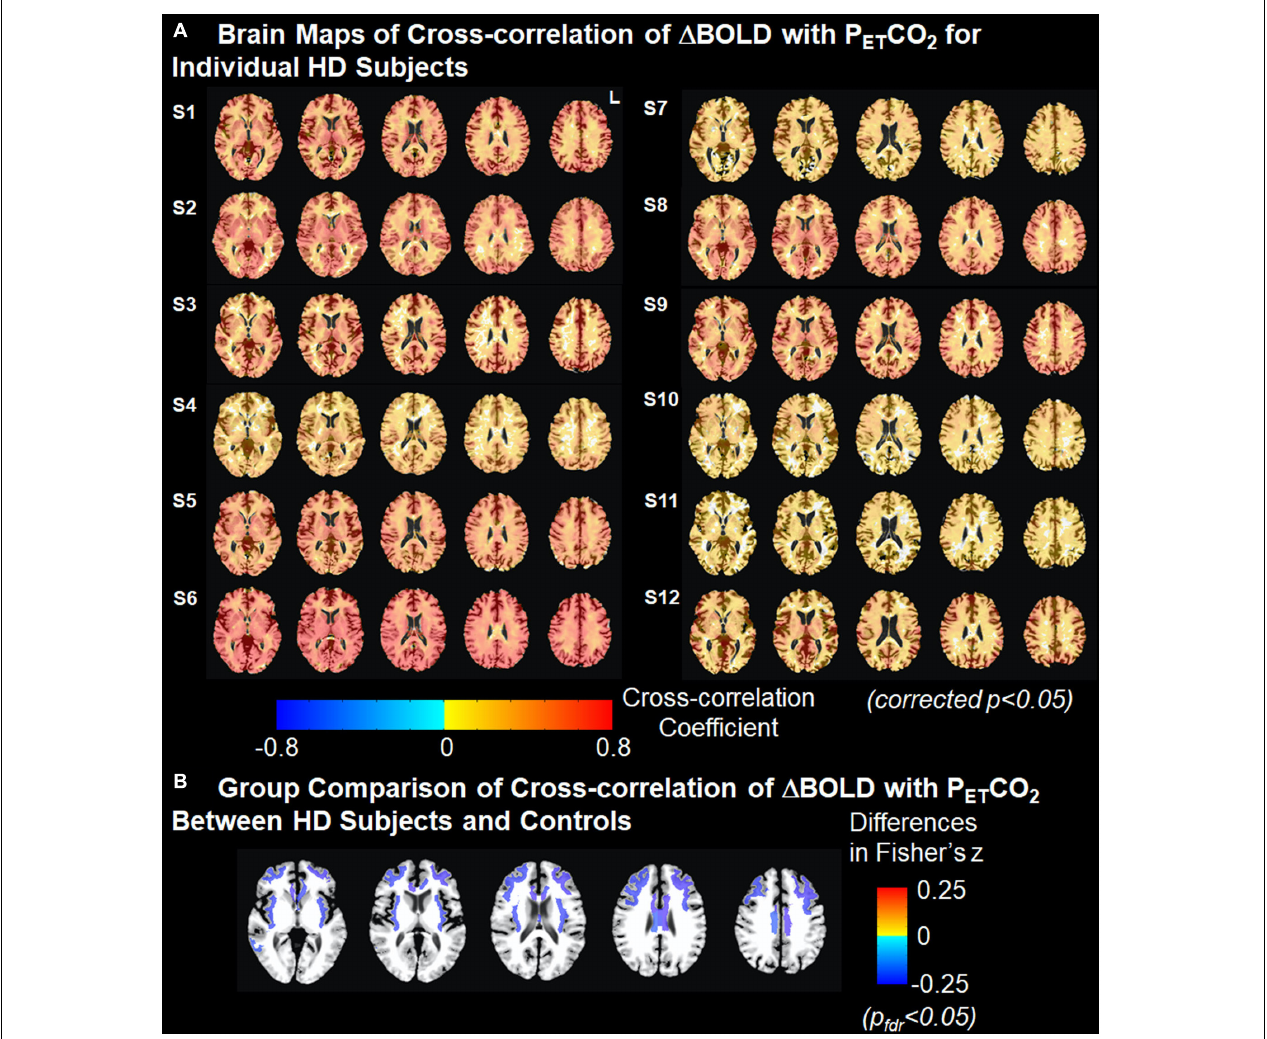
FIGURE 2 | Cross-correlation of (cid:49) BOLD with P ET CO 2 . (A) Brain maps of cross-correlation of (cid:49) BOLD with P ET CO 2 for individual HD subjects. The strength of cross-correlation increases from light color to dark color. Brain regions without color indicate that the (cid:49) BOLD in these areas are not correlated with the changes in P ET CO 2 . Multiple comparisons are corrected using clustering at an overall p < 0.05. (B) Group comparison of Fisher-transformed cross-correlation values between HD subjects and controls after adjusting for age. Cold colors represent the weaker cross-correlation found in HD subjects than in controls. Multiple comparisons were corrected at false discovery rate p fdr <